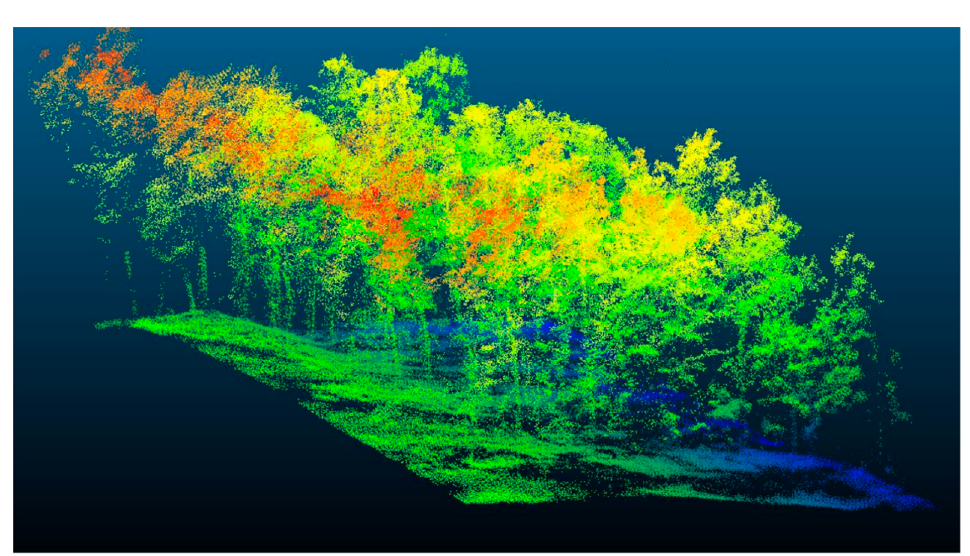
Figure 2. Airborne Laser Scanning (ALS) point cloud. Tile of ALS point cloud showing the heterogeneity of the forest stand structure. The density of points was higher for the uppermost trees and lower for the ground due to the dense canopy of tree crowns, which hinders the vertical penetration of the pulses.